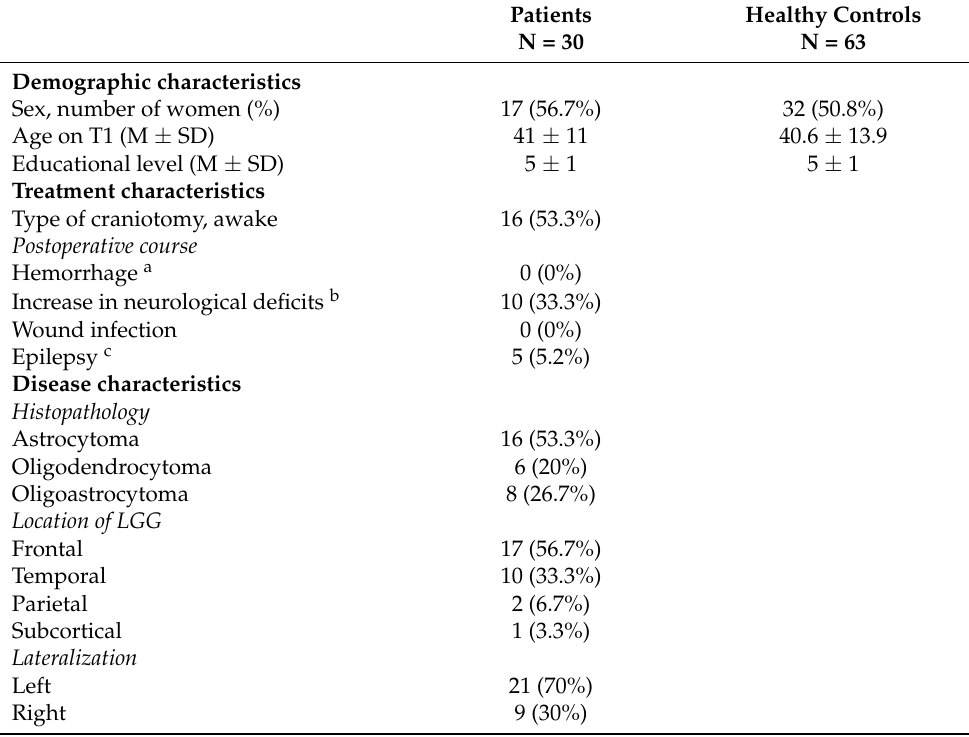
Table 1. Characteristics of patient group on T1 and healthy